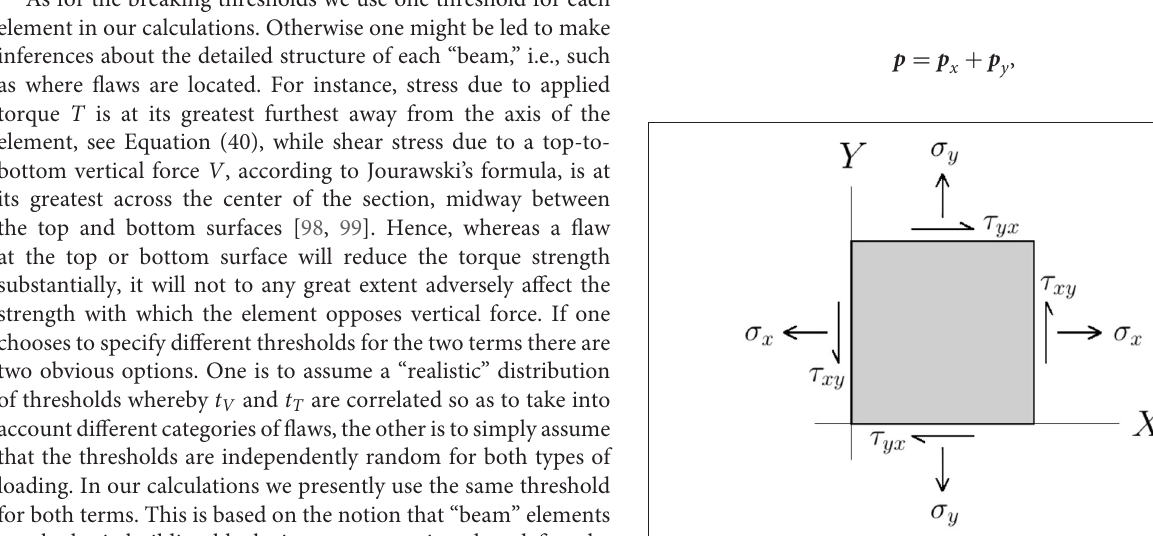
FIGURE 4 | Elastic body element showing components of normal stress, σ x and σ y , and components of shear, τ xy and τ yx , on those surfaces that are parallel to the Z -axis.